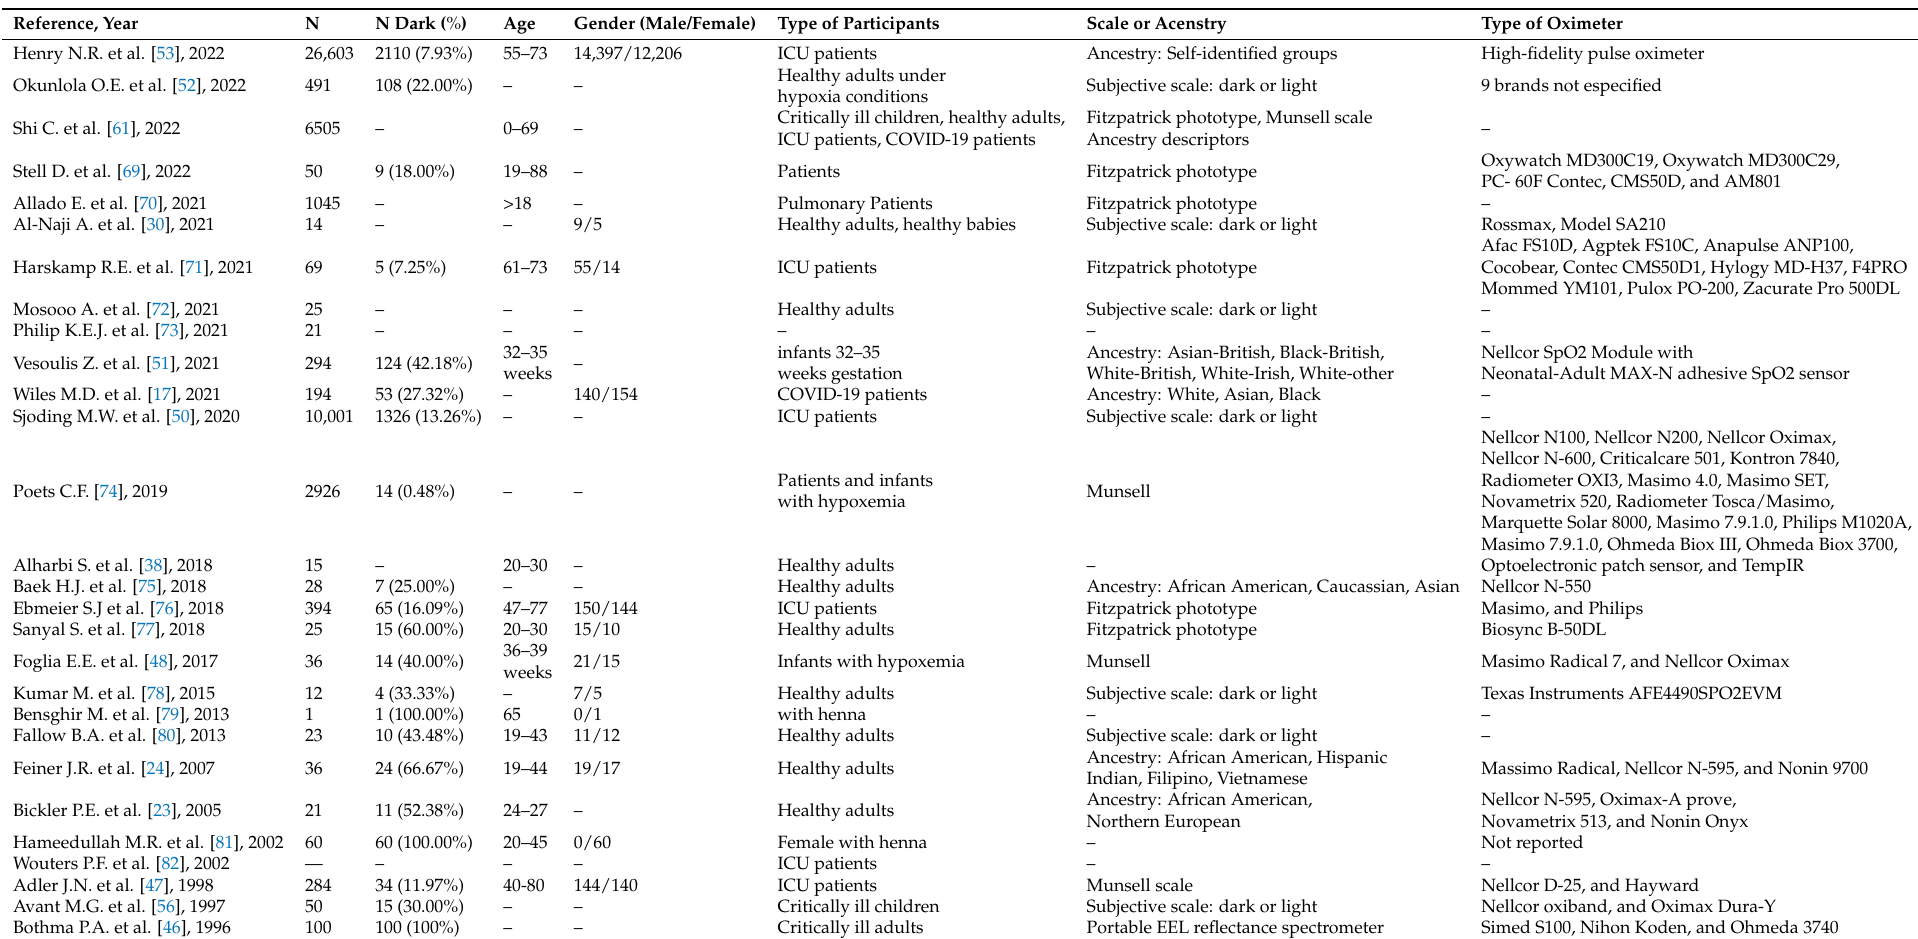
Table 3. Selected studies from the search query sorted by year of publication. First author’s name, publication year, size of the sample, number of dark skinned subjects, gender, type of participant, and type of oximeter employed are